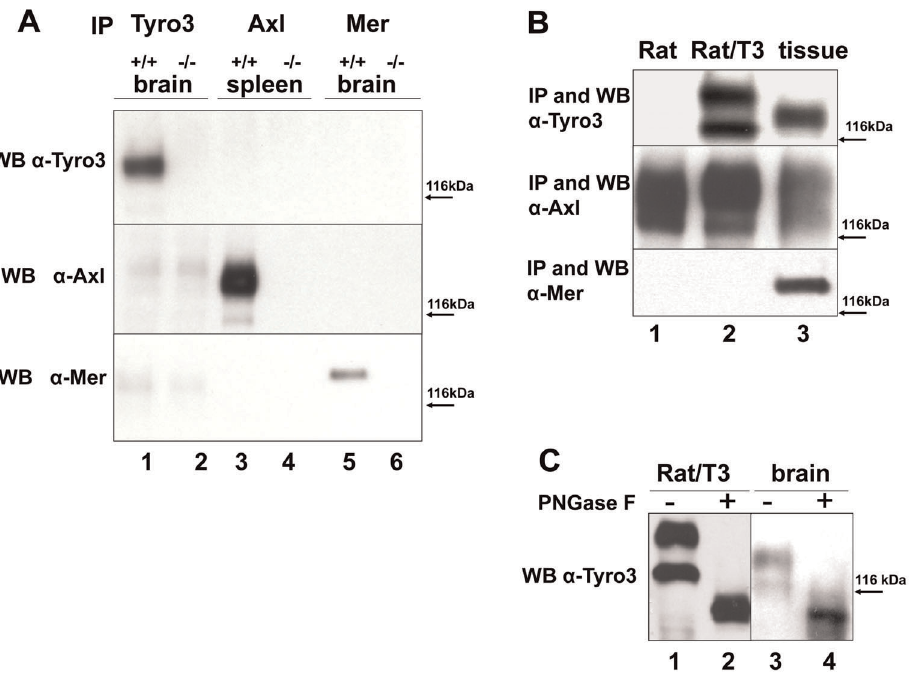
Figure 1 . Characterization of anti-TAM specific antibodies and TAM expression in Rat2 cells. To determine whether the antibodies used to immunoprecipitate (IP) and detect Tyro3, Axl, and Mer ‘‘TAMS’’ by Western blotting were specific for each receptor, we used tissues derived from knockout mice for each of the TAMS. Whole brain and spleen detergent extracts were prepared from wild-type (wt) ( + / + ) C57BL/6 mice and from tyro3 2 / 2 , axl 2 / 2 , and mer 2 / 2 knockout mice. As shown in panel A , After normalization for protein concentration, Tyro3 and Mer were IPed from brain detergent extracts (lanes 1–2 and 5–6 respectively) and Axl was IPed from spleen extracts (lanes 3–4). Tyro3 was IPed using a -FN2, Axl using # AF154 and Mer # AF591. SDS-PAGE was performed using 8% gels followed by Western blot analysis. The membranes were probed with a - Tyro3 (5424 serum 1:3,000, top panel), affinity purified rabbit a -Axl (serum 1:3,500, center panel), and rabbit a -Mer (1:5,000 bottom panel) . These antibodies were used to characterize Tyro3, Axl, and Mer expression in Rat2 and Rat2/T3V5 cells as shown in panel B. Detergent cell extracts were prepared from untransfected Rat2 cells ( Rat, lane 1 ), stably Tyro3 transfected Rat2/T3V5 cells ( Rat/T3 lane 2 ), brain tissue extract ( lane 3, top and bottom panels ) or spleen tissue extract (lane3, center panel). After normalization of tissue extracts for protein concentration, Tyro3, Axl and Mer were immunoprecipitated (IPed) (see Fig. 1A for antibodies). SDS-PAGE was performed using 8% gels followed by Western blot analysis. The membranes were probed against Tyro3 (top panel), Axl (center panel), and Mer (bottom panel), as described in Fig. 1A. The observed differences in Tyro3 molecular weight depending on the source are due in part by N-linked glycosylation as shown in panel C. Detergent extracts were prepared from Rat2/T3V5 cells ( Rat/T3, lanes 1 and 2 ), and adult rat brain tissue ( brain , lanes 3 and 4) . Cell and tissue extracts were incubated overnight without ( 2 ) or with ( + ) PNGase F. SDS-PAGE was performed using 8% gels followed by Western blot analysis using a -Tyro3